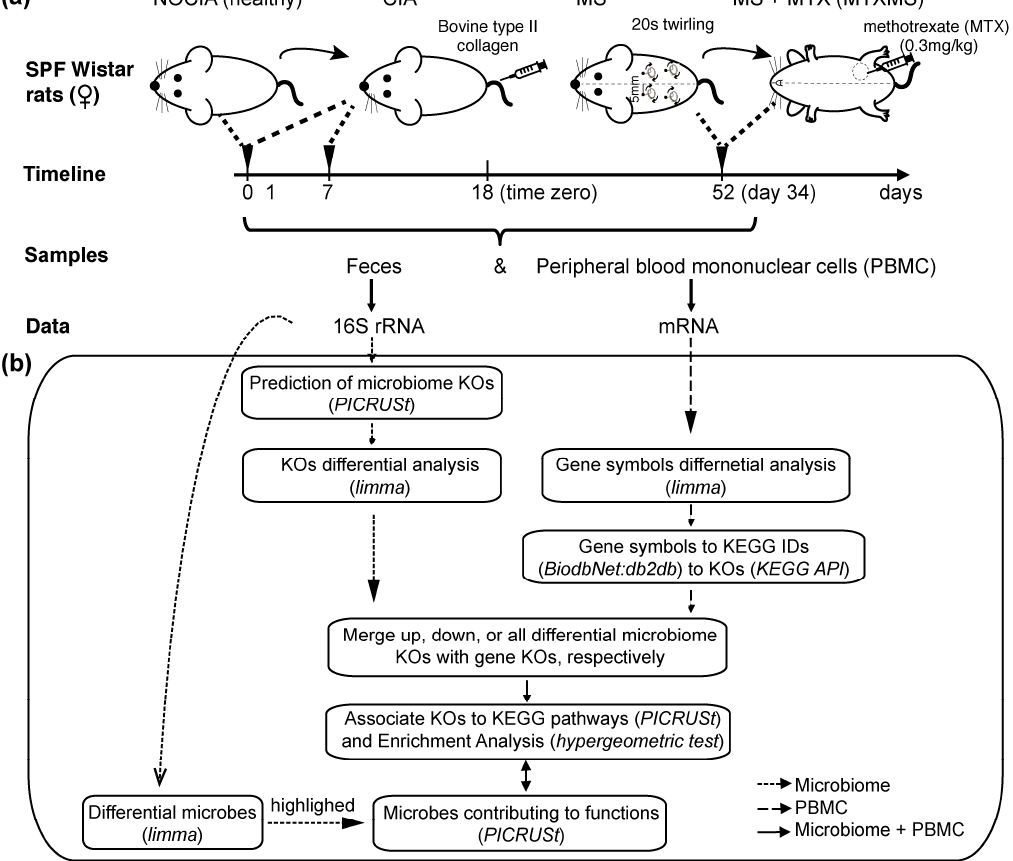
Figure 1. Workflow of the host-microbiome interaction analysis. ( a ) Summary of the experimental design and data collected. See Methods for full details on collagen induced arthritis (CIA) induction; ( b ) Functional integrations of blood genes and gastrointestinal microbiomes. Dashed arrows indicate single omic analyses (16S-rRNA microbiome data alone and PBMC transcriptomics alone), and solid arrows represent microbiome and PBMC genes integration steps. NOCIA, non-induced healthy rat; MS, mechanical stimulation; MTX, methotrexate; MTXMS, MTX in conjunction with MS; KEGG, Kyoto Encyclopedia of Genes and Genomes; KO, KEGG orthology; limma , Linear Models for Microarray data; PICRUSt, Phylogenetic Investigation of Communities by Reconstruction of Unobserved States.